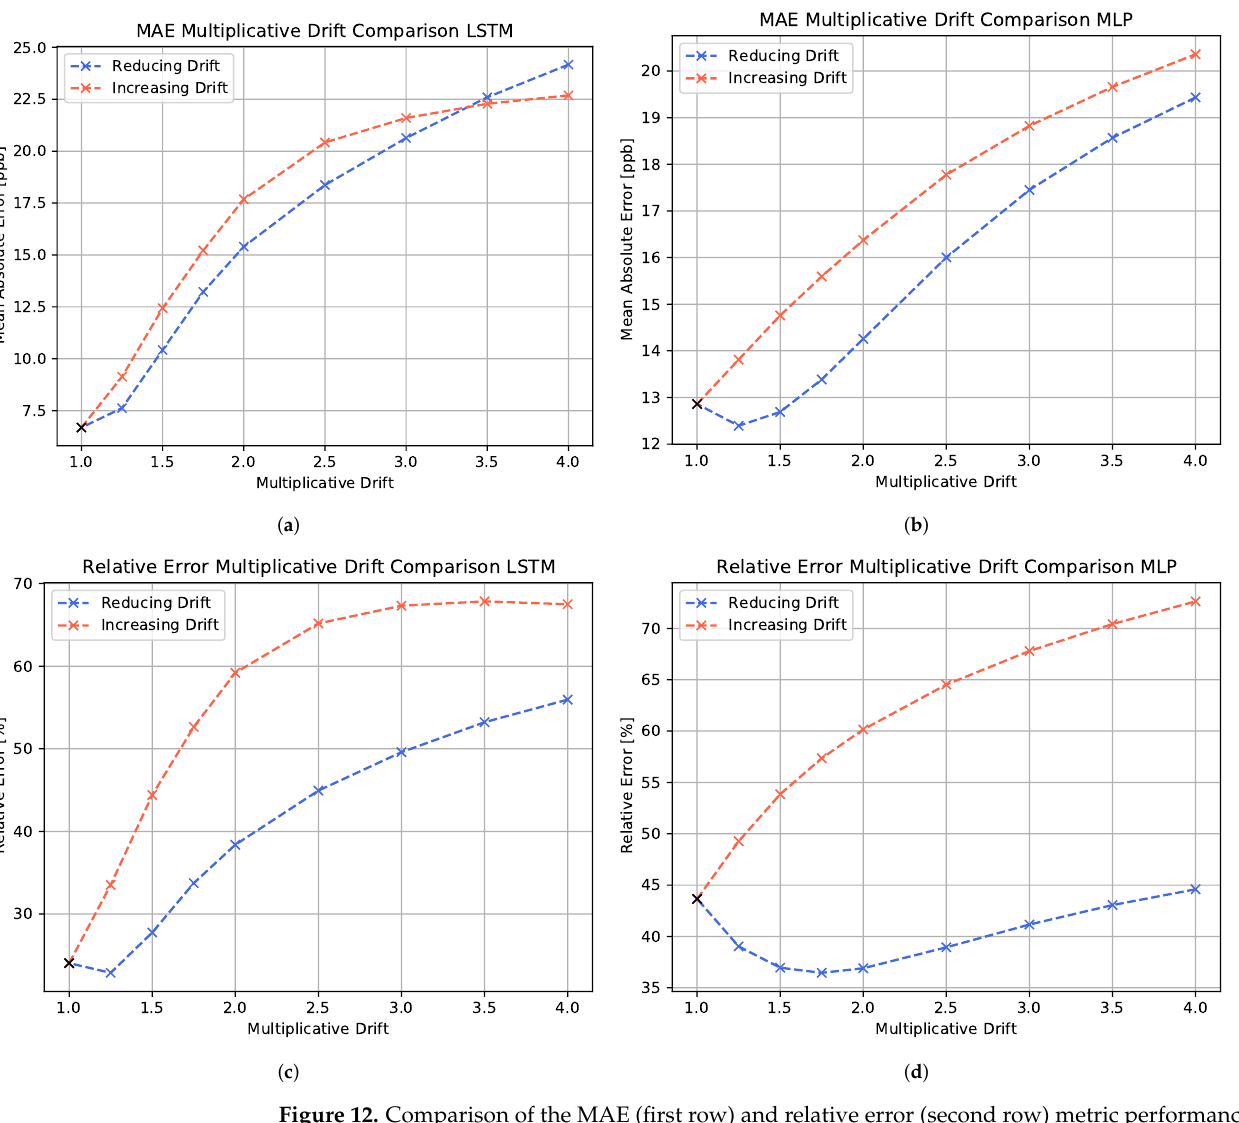
Figure 12. Comparison of the MAE (first row) and relative error (second row) metric performances of differently trained algorithms with respect to different levels of multiplicative drift. The blue curve represents the reducing drift (multiplicative factor < 1), whereas the red curve represents the increasing drift performance (multiplicative factor > 1). ( a , c ) show the LSTM model, whereas ( b , d ) show the MLP model